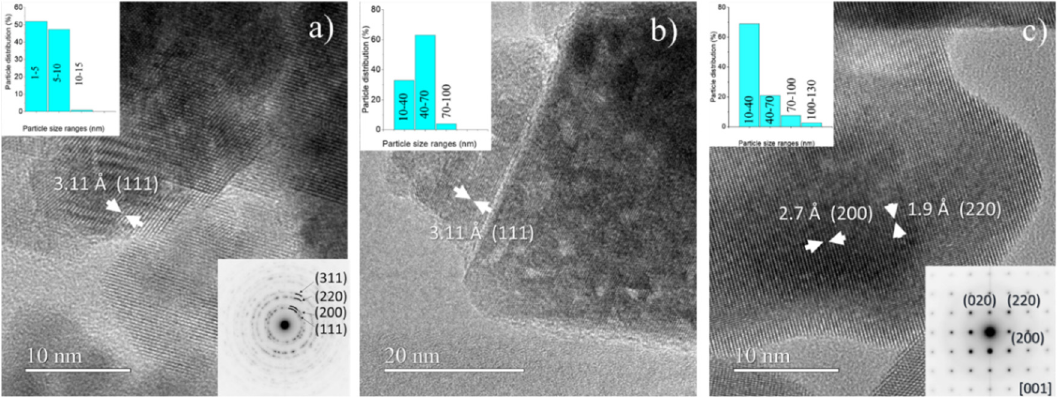
Figure 3. High-magnification images, corresponding ED patterns and particle size distribution for ( a ) Ce-pH7, ( b ) Ce-pH13 and ( c ) Ce-CMK3 samples.